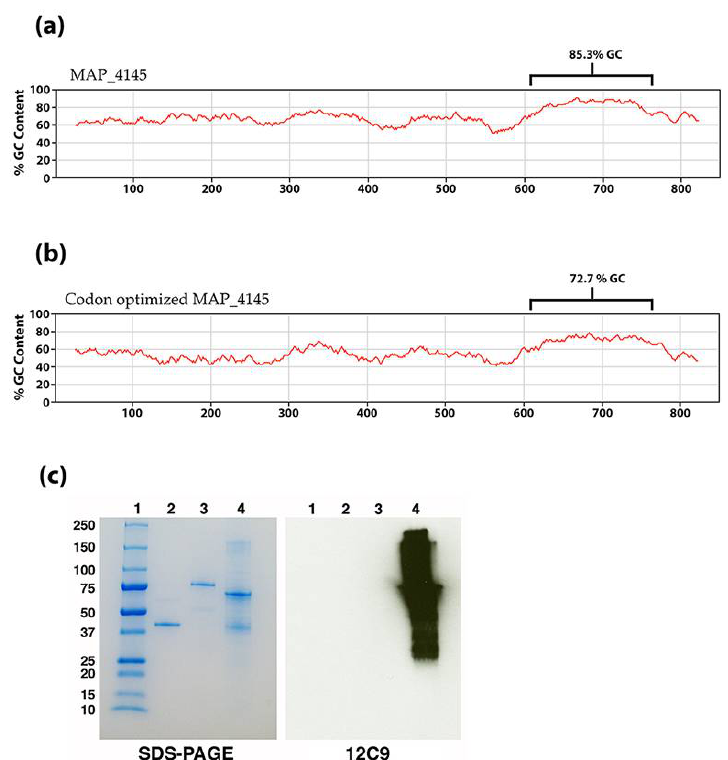
Figure 4. Codon optimized MAP_4145 reacts with mAb 12C9. The native ( a ) and codon optimized ( b ) percent G-C plots show the effect of replacing guanine or cytosine nucleotides with adenine and thymine at redundant locations. The brackets identify a 150 bp region that is especially rich in GC content. ( c ) SDS-PAGE and corresponding immunoblot shows that 12C9 reacts specifically and strongly to the codon optimized MAP_4145. Lanes: 1 = protein size markers, 2 = MAP_1609c, 3 = MAP_3842, and 4 = codon optimized MAP_4145.